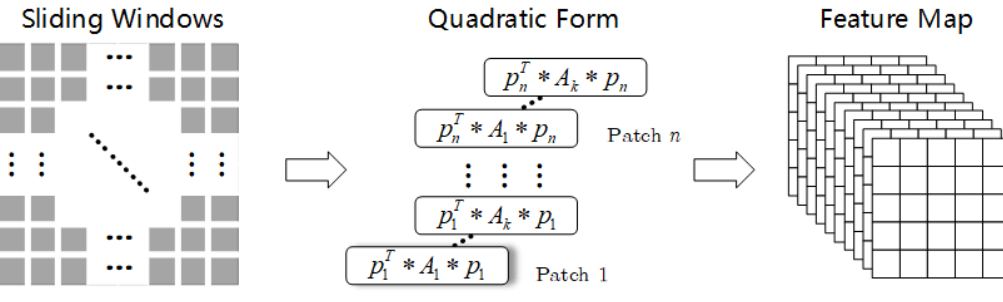
Figure 3. Quadratic